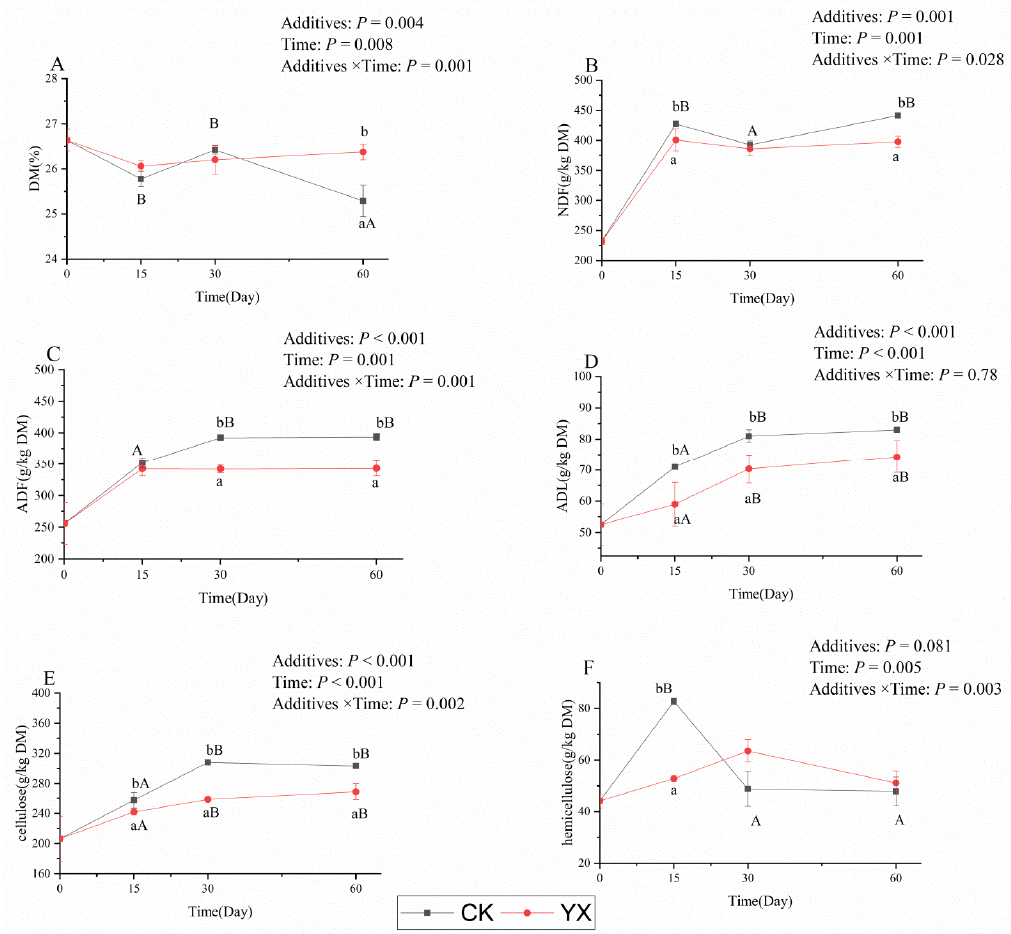
Figure 2. Changes in DM ( A ), NDF ( B ), ADF ( C ), ADL ( D ), cellulose ( E ), and hemicellulose ( F ) in alfalfa silages during ensiling for 60 d. Values with different superscript lowercase letters show significant differences among treatments on the same ensiling day, values with different superscript capital letters show significant differences among ensiling days in the same treatment ( p < 0.05). CK, control; YX, inoculated with commercial LAB YX; DM, dry matter; NDF, neutral detergent fiber; ADF, acid detergent fiber; ADL, acid detergent lignin.